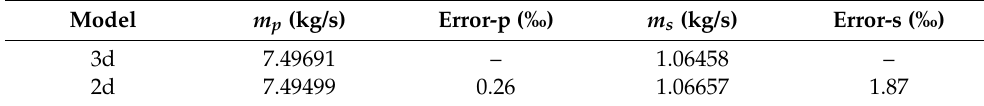
Table 4. Grid independence analysis results.